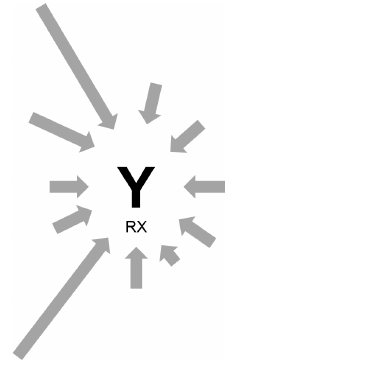
Figure 4. Illustration for the physical interpretation of Nakagami